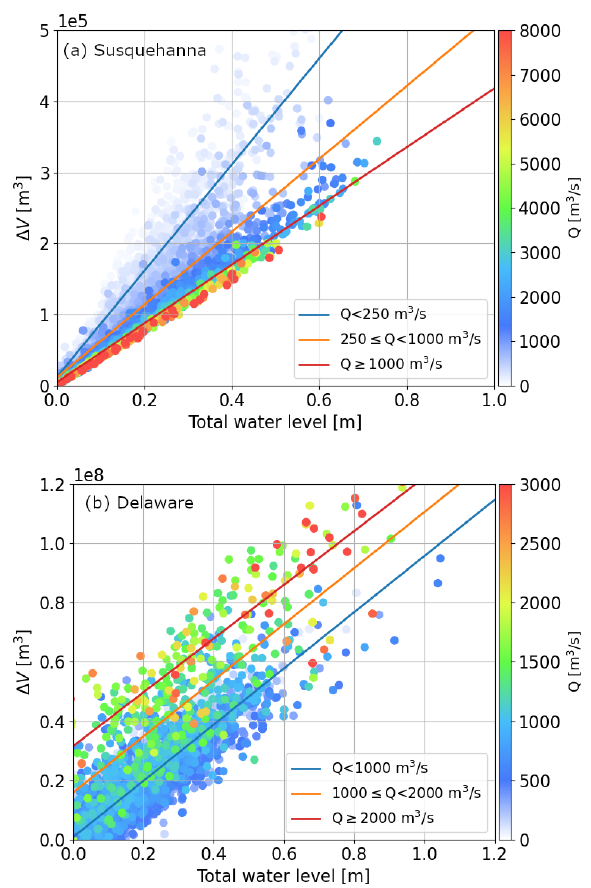
Figure 8. Scatter plot of (cid:49)V against TWL in the Susquehanna River (a) and Delaware River (b) . Colored circles represent the corresponding river discharge ( Q ). The TWL and Q data are ob- tained from gauges 8573364 and 01578310, respectively, for the Susquehanna River, and from gauges 8546252 and 01463500 for the Delaware River. The solid lines are the fitted linear regression under different discharge ranges.